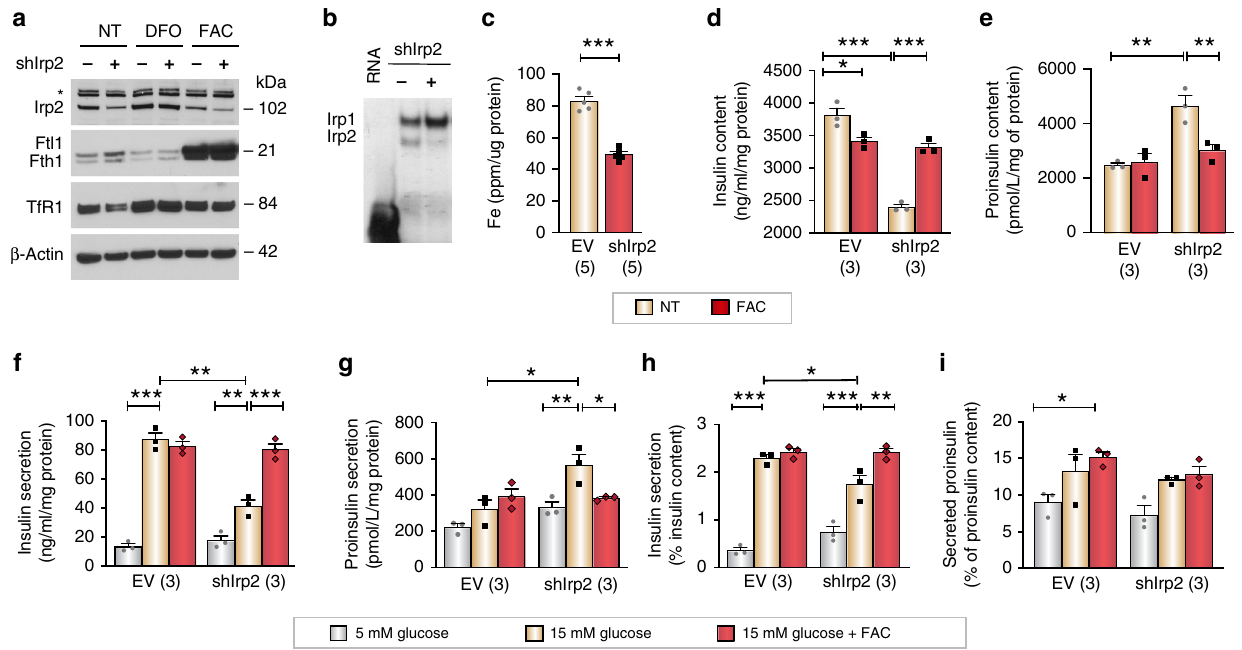
Fig. 6 Iron normalizes insulin and proinsulin secretion in Irp2-de fi cient insulinoma cells. a Western blotting of Irp2, Ftl1, Fth1, and TfR1 in INS-1 832/13 insulinoma cells expressing a shIrp2 or empty vector (EV) control ( − ). Cells were grown in medium with no treatment (NT) or in the presence of DFO (50 µ M) or FAC (50 µ g/mL) for 18 h. β -Actin is a loading control. Asterisk, nonspeci fi c band. b Irp1 and Irp2 RNA-binding activity was assessed in EV ( − ) and shIrp2 ( + ) cell lysates by RNA-EMSA. Whole-cell lysates were incubated with a 32 P-labeled ferritin IRE RNA probe followed by resolution of the Irp1- and Irp2-RNA complexes on non-denaturing polyacrylamide gels. Irp1- and Irp2-RNA complexes and 32 P-labeled ferritin IRE are indicated. c The total iron content in EV and shIrp2 cells as quanti fi ed by ICP-MS and normalized to total cellular protein. d – g The total insulin ( d ) and proinsulin content ( e ) and glucose-stimulated insulin ( f ) and proinsulin ( g ) secretion in EV and shIrp2 cells grown in the presence of FAC overnight and assayed under basal (5 mM) glucose and after stimulation with high (15 mM) glucose for 1 h. h , i Samples in f and g were normalized to total insulin content ( f ) or total proinsulin ( g ) content. n = 3 independent biological experiments. Data are expressed as means ± s.e.m., one-way ANOVA with Tukey ’ s multiple comparisons test for d – i and unpaired two-tailed Student ’ s t test for c , ** p < 0.01. Source data are provided as a Source Data fi